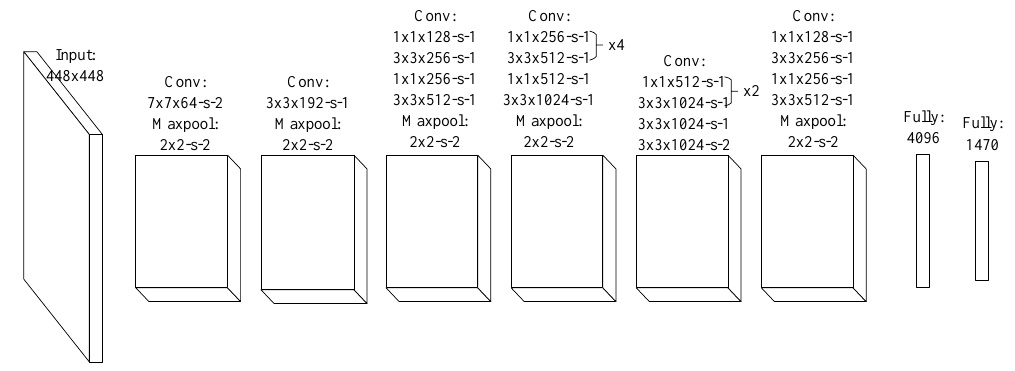
Figure 2. YOLO network structure diagram.